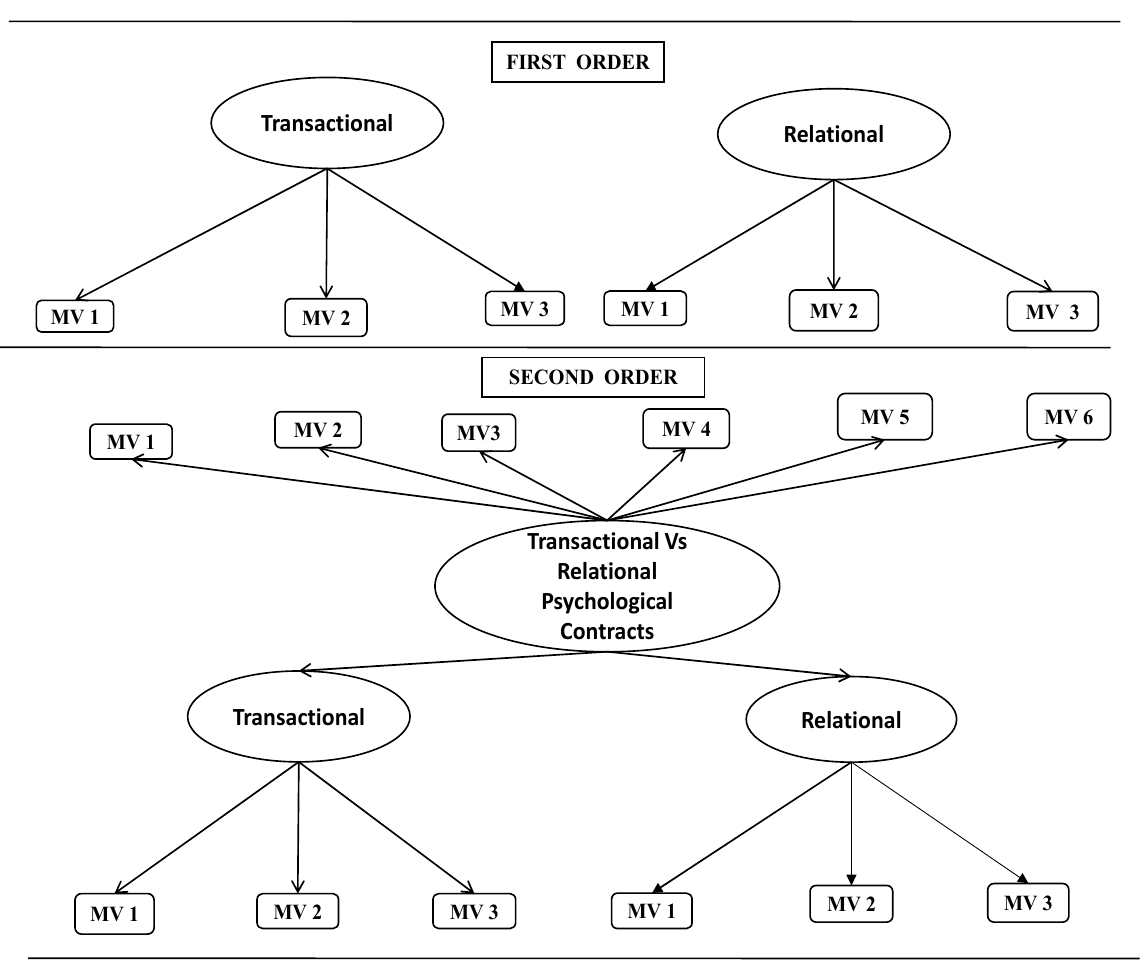
Figure 2. Hierarchical reflective model on the transactional vs. relational psychological contracts.